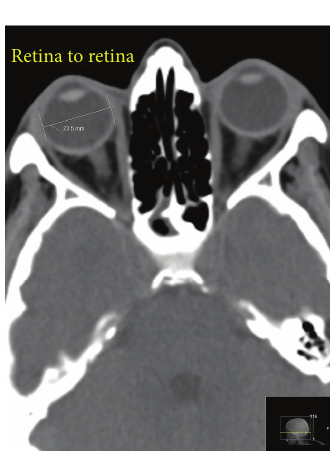
Figure 2: The cornea to optic canal anterior opening depth of the orbit and the sclera to sclera diameter of the